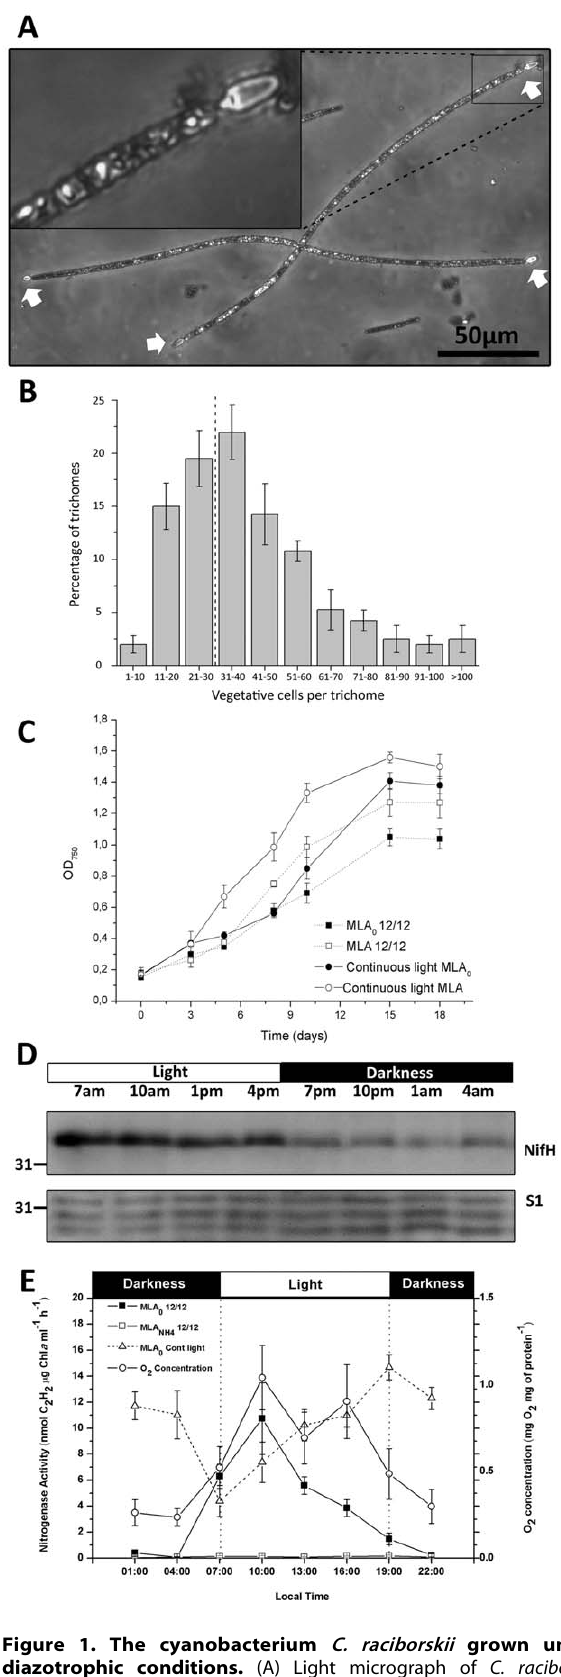
Figure 1. The cyanobacterium C. raciborskii grown under diazotrophic conditions. (A) Light micrograph of C. raciborskii trichomes, magnified 40x. Note the terminal heterocysts at the end